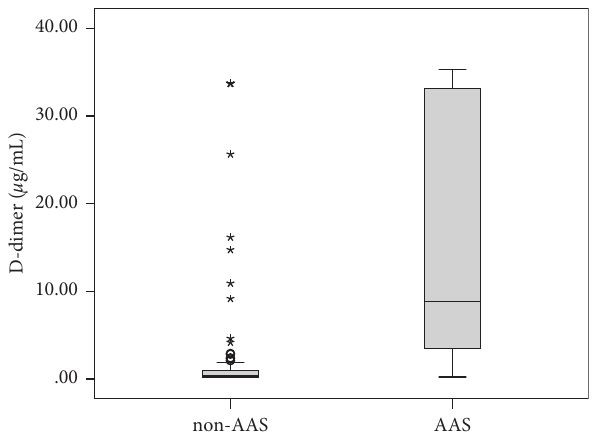
Figure 1: Box plot for D-dimer plasma levels between the ASS and non-ASS groups (AAS, acute aortic syndrome).